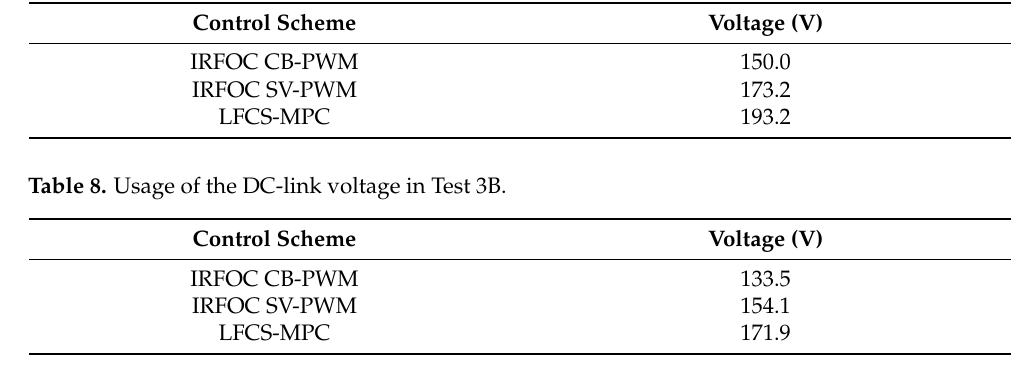
Table 7. Usage of the DC-link voltage in Test 3A.